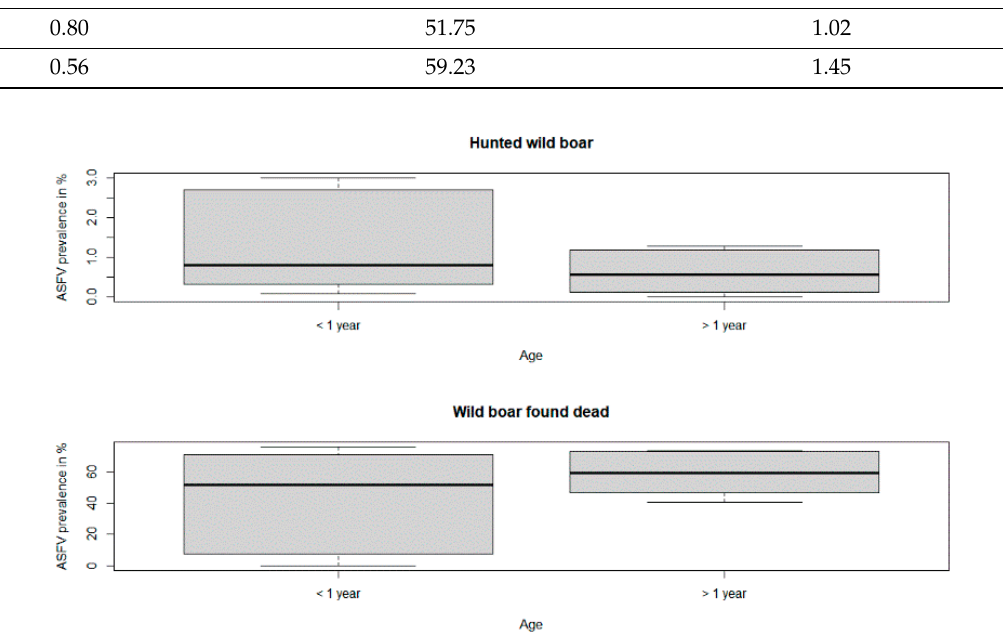
Figure 5. African swine fever virus prevalence estimates of hunted wild boar and wild boar found dead in the two age classes. The horizontal lines that form the top of the boxes illustrate the 75th percentile. The horizontal lines that form the bottom indicate the 25th percentile. The horizontal lines that intersect the box represent the median ASFV prevalence per age class. Whiskers indicate maximum and minimum values that are no more than 1.5 times the span of the interquartile range and the open circles represent outliers, which are single values greater or less than the extremes indicated by the